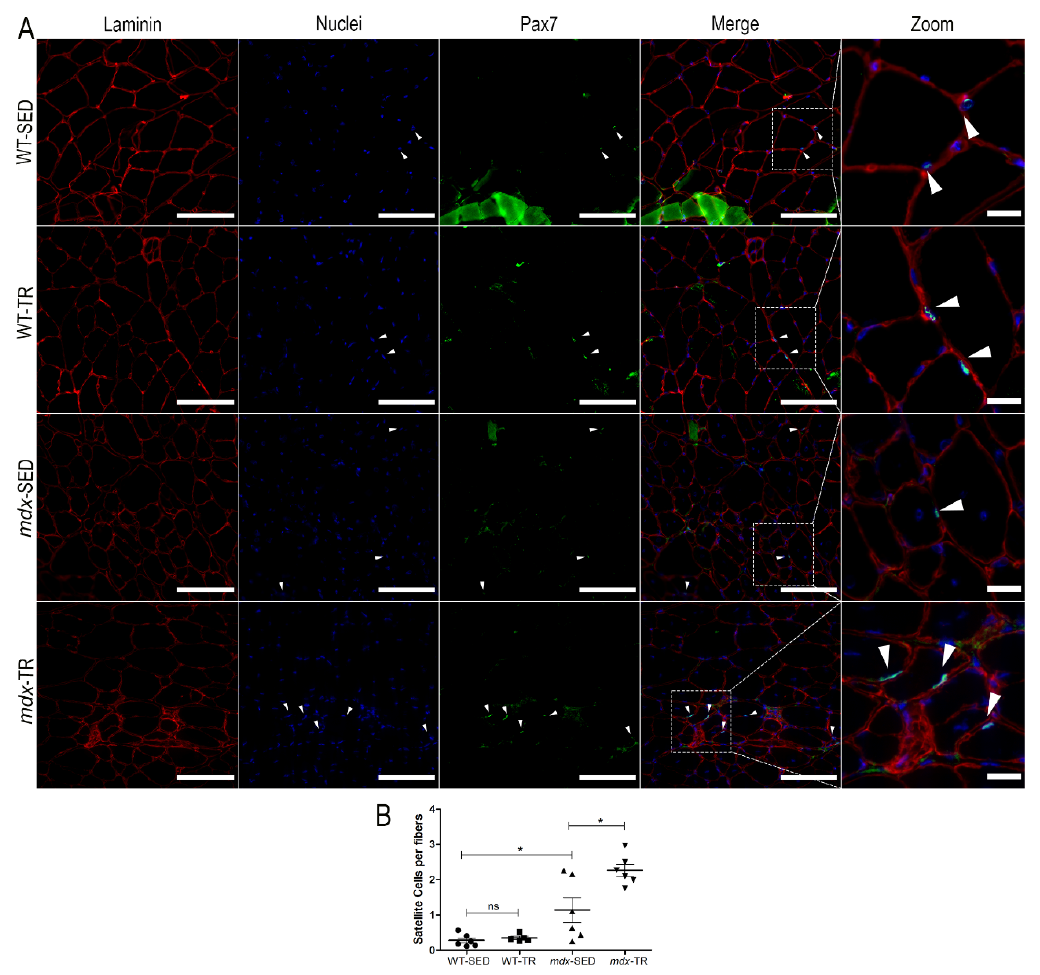
Figure 3. Satellite cell number (Pax7 marker) is increased in dystrophic muscles after 37 sessions of low-intensity exercise. ( A ) Representative images of immunostaining of quiescent/activated satellite cells through the Pax7 antibody. Laminin (red, Cy5), nuclei (blue, DAPI), and Pax7 (green, FITC) are shown. White arrows: Indication of SCs (Pax7 + underlying nuclei). Images were obtained with the ImageXpress XLS System microscope at 40× magnification. Scale bar = 100 µm (laminin, nuclei, Pax7 and merged panels). All zoomed areas provided better visualization of the SCs (scale bar = 20 µm). SCs were identified by their localization below the laminin superimposed with the nuclei. ( B ) As expected, the WT-SED group had few quiescent/activated SCs when compared to the mdx -SED group. After a low-intensity training for 37 sessions, the mdx -TR group showed increased SC content when compared to the mdx -SED group. * p < 0.05; ns: not significant. Round symbol: WT-SED; Square symbol: WT-TR; Triangle symbol: mdx- SED; Inverted triangle symbol: mdx -TR. Abbrevia- tions: WT-SED: sedentary wildtype; WT-TR: trained wildtype; mdx -SED: sedentary mdx ; mdx -TR: trained mdx . Additionally, SCs in differentiation/fusion were identified using F5D, a myogenin marker (Figure 4A). As expected, the WT-SED group had fewer SCs in differentiation/fu- sion when compared to the mdx -SED group (WT-SED × mdx -SED, p < 0.05) (Figure 4B).